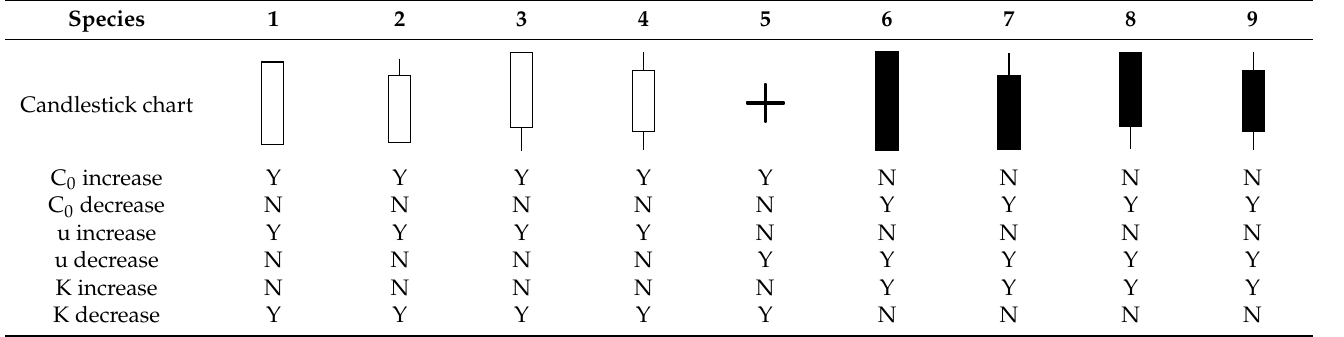
Table 2. Correspondence between nine basic candlestick chart forms and water quality diffusion factors.